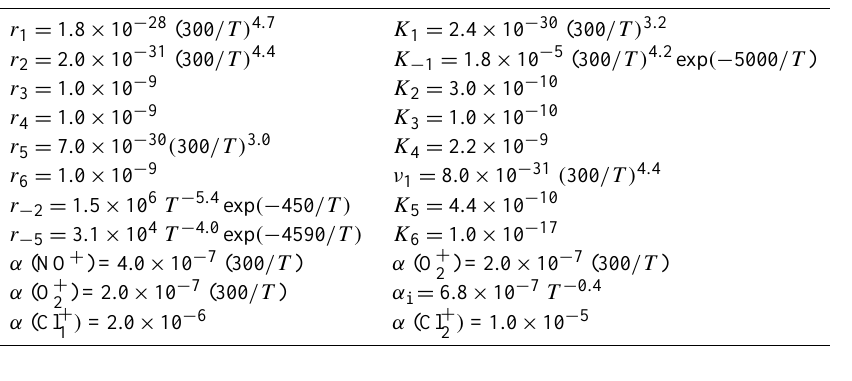
Table 1. Rate constants (cm 3 s − 1 ) included in the expressions for NO + and O + of NO + and O + with electrons and negative ions, and cluster ion dissociative recombination coefficients (from Smirnova, 1982, 1983a, b). 2